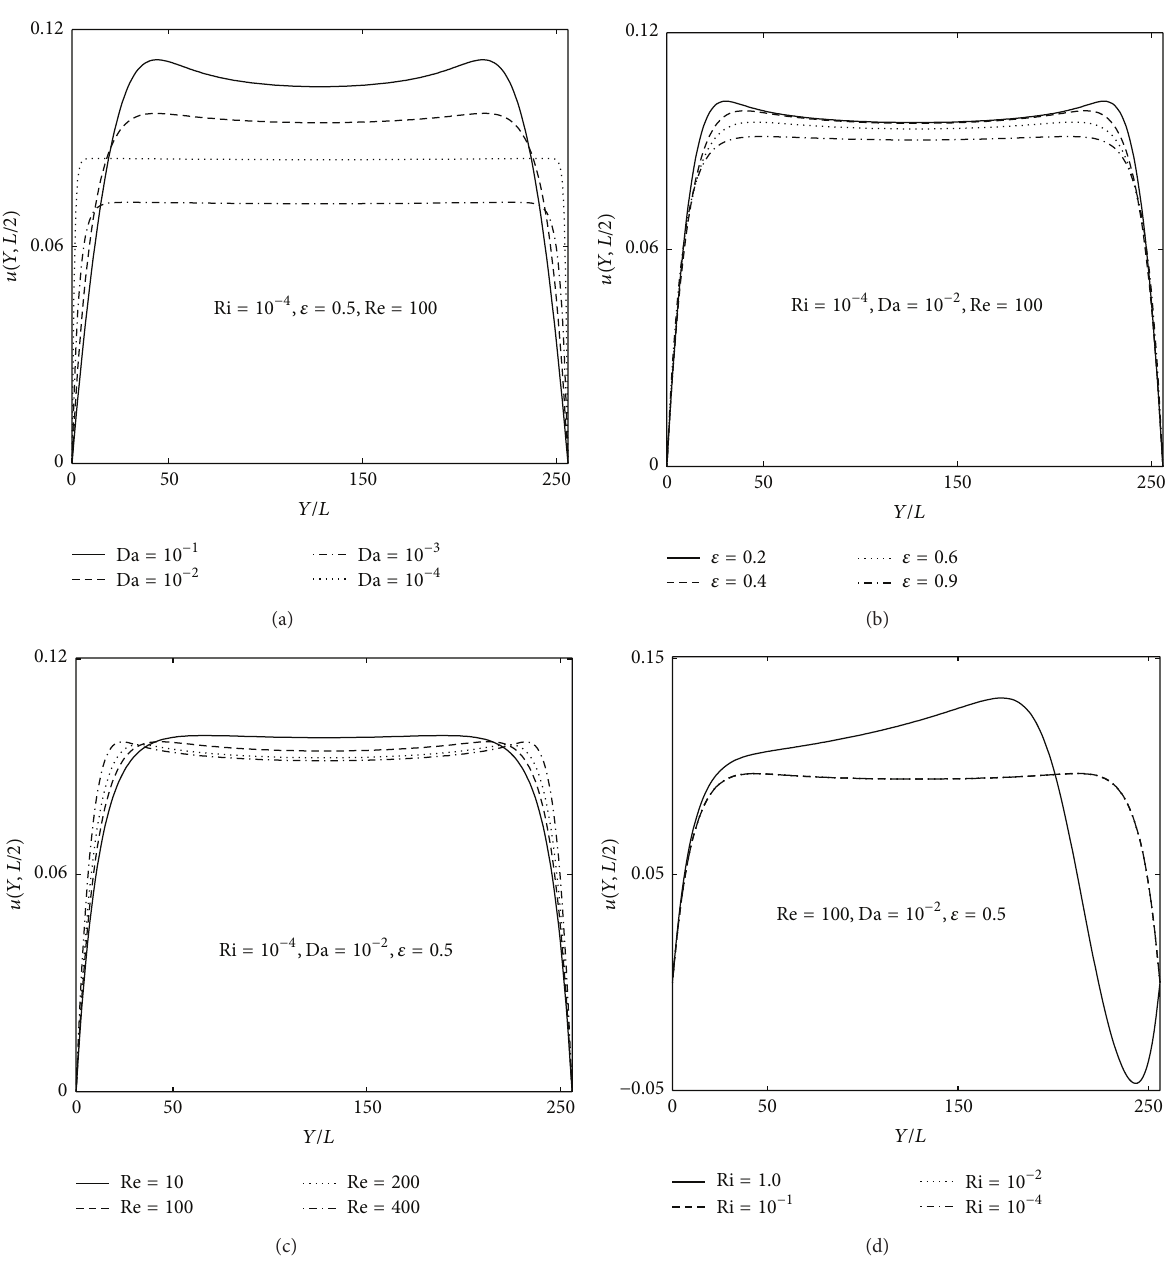
Figure 6: Horizontal velocity profiles in the vertical midplane for different (a) Darcy numbers, (b) porosities, (c) Reynolds numbers, and (d) Richardson